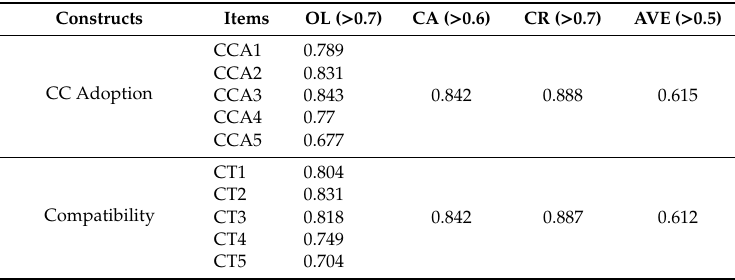
Table 5. Constructs’ reliability and